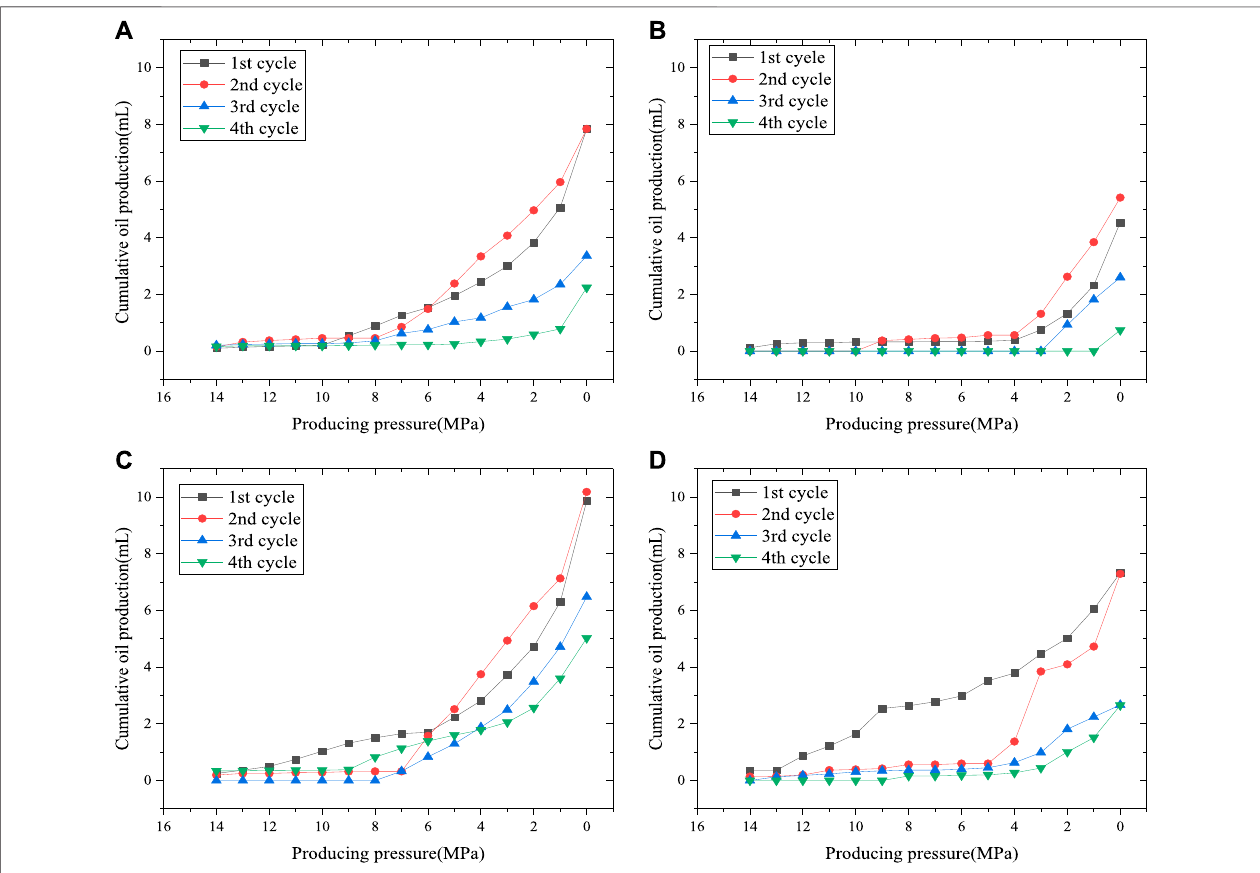
FIGURE11| Cumulativeoilproductionforeachcycleofdualsandpack. (A) HighpermeabilitysanpackofN 2 huff-n-puff. (B) LowpermeabilitysandpackofN 2 huff- n-puff. (C) High permeability sandpack of N 2 huff-n-puff assisted by viscosity reducer. (D) Low permeability sandpack of N 2 huff-n-puff assisted by viscosity reducer.